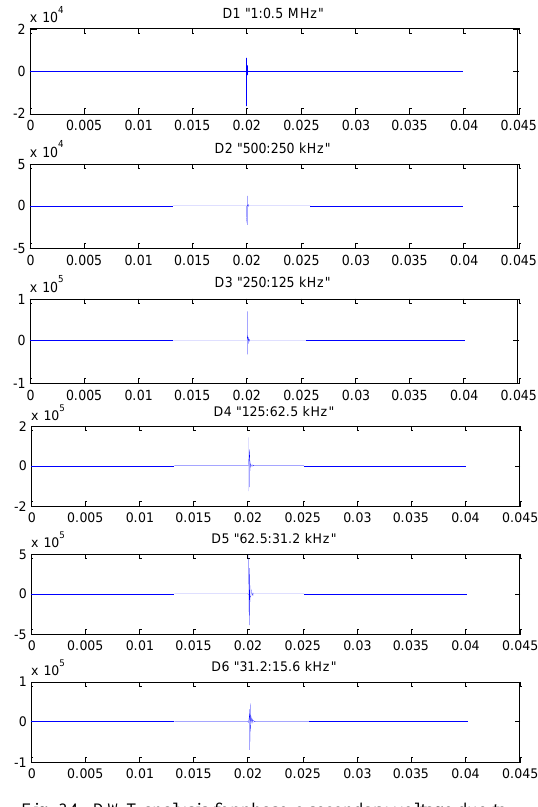
Fig. 34. DWT analysis for phase-c secondary voltage due to resonance for the studied power